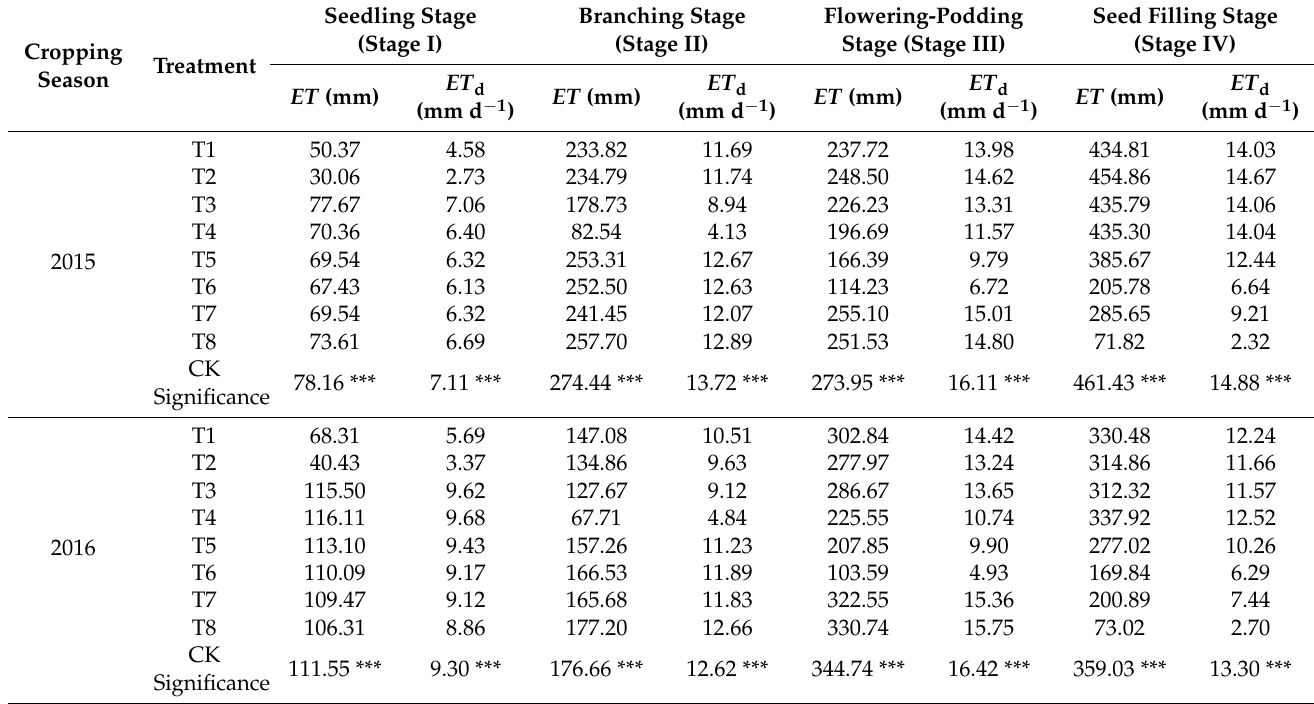
Table 5. Evapotranspiration ( ET ) and average daily evapotranspiration intensity ( ET d ) of soybean at each growth stage under different treatments in the 2015 and 2016